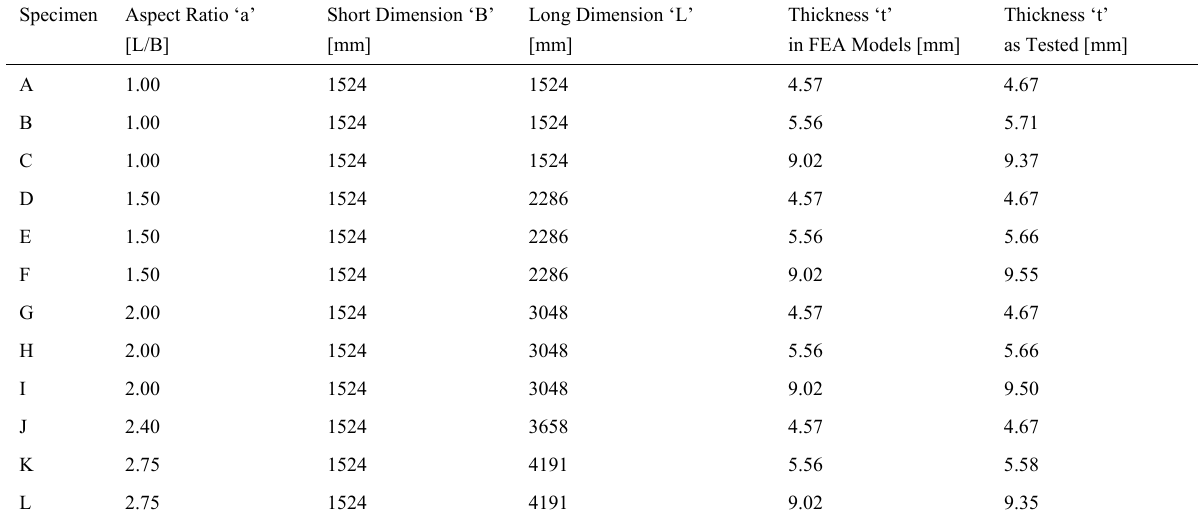
Table 1: Specimens Tested Previously by Enclos